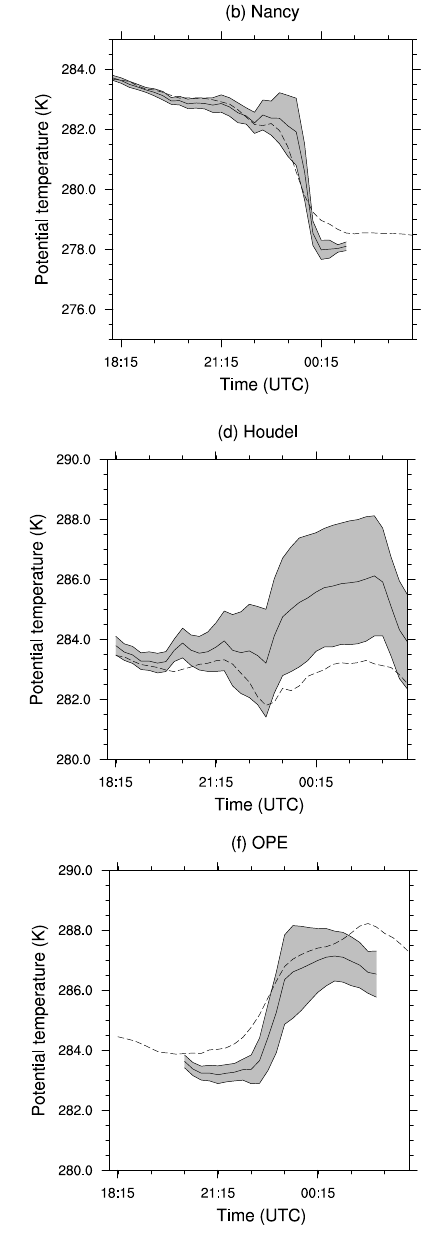
Figure 8. Time series of modelled potential temperature at 2 m (left panel: a , c , e ) and at 50 m (right panel: b , d , f ) for Nancy, Houdel, and OPE. The grid point value for the observed sites is represented by the dashed line for M500m and by solid line for M50m. The standard deviations at 500 m horizontal scale are indicated by the grey areas.